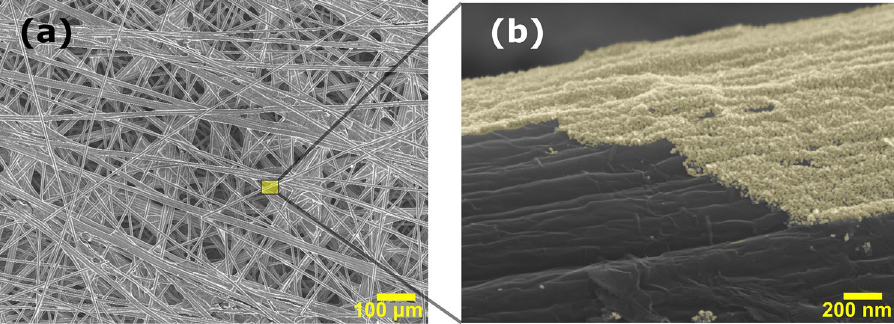
Figure 1. ( a ) Scanning electron microscopy (SEM) image of the C-paper coated with Al-doped ZnO NPs. ( b ) Close-up image of a thin uniform layer of Al-doped ZnO NPs (artificially colored layer) deposited on the surface of a C-fiber.